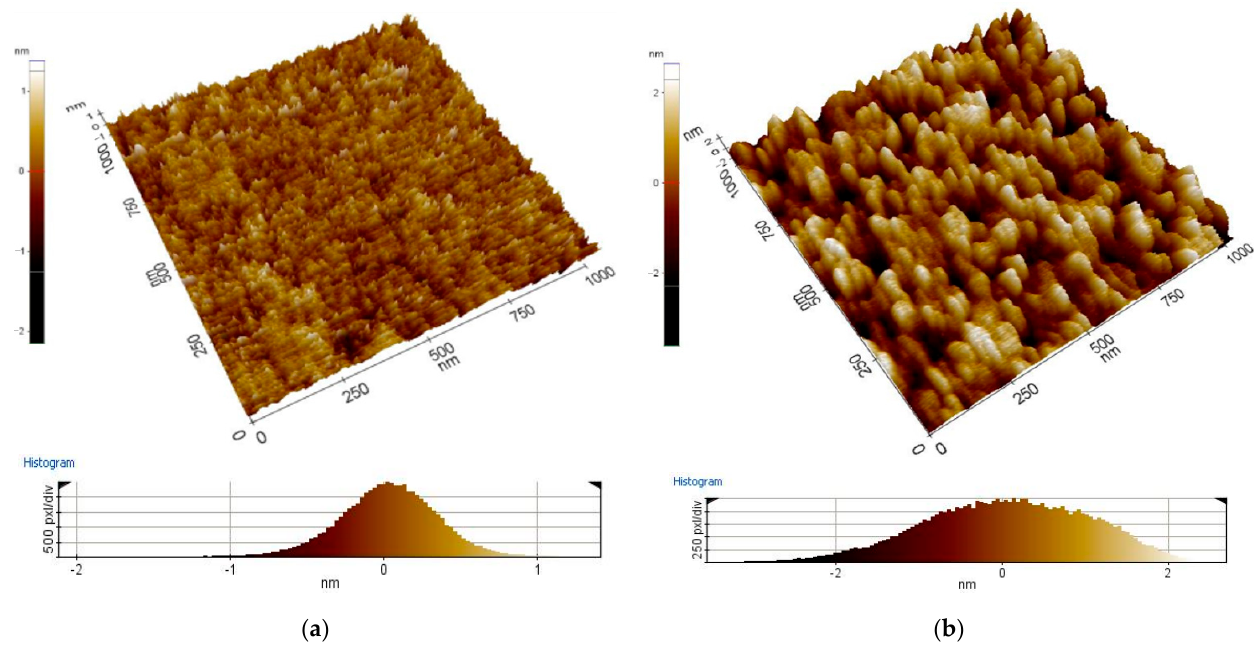
Figure 2. Topography of the applied ITO layers with thickness ( a ) 25 nm, ( b ) 135 nm (chosen example) (AFM).